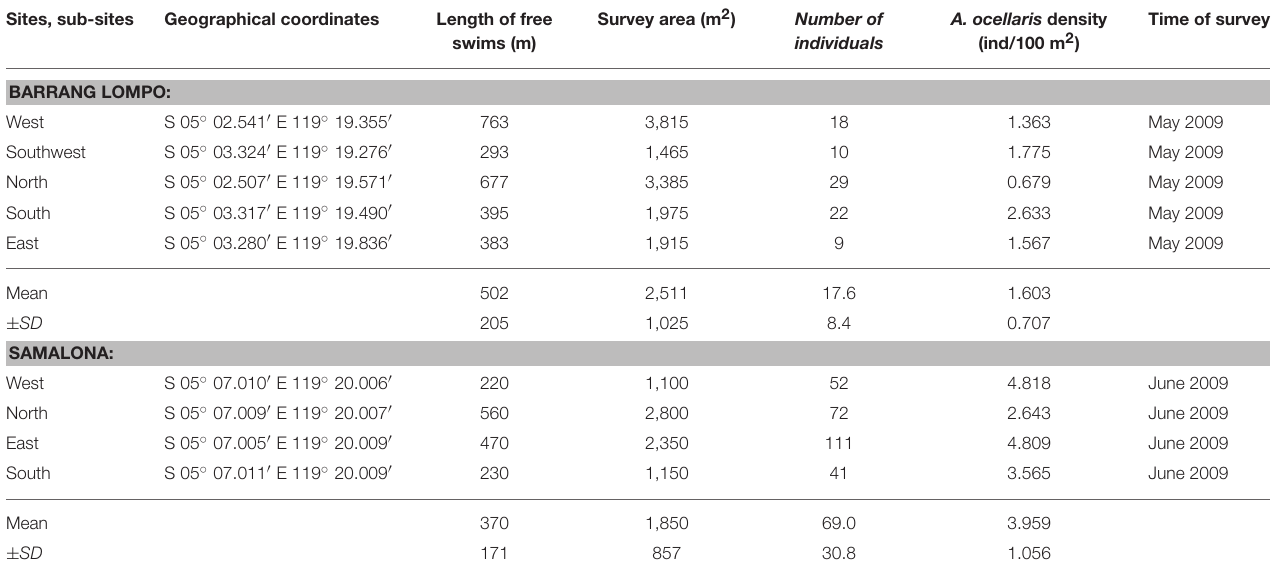
A. ocellaris density Survey area (m 2 ) Number of Time of survey individuals swims (m) (ind/100 m 2 )